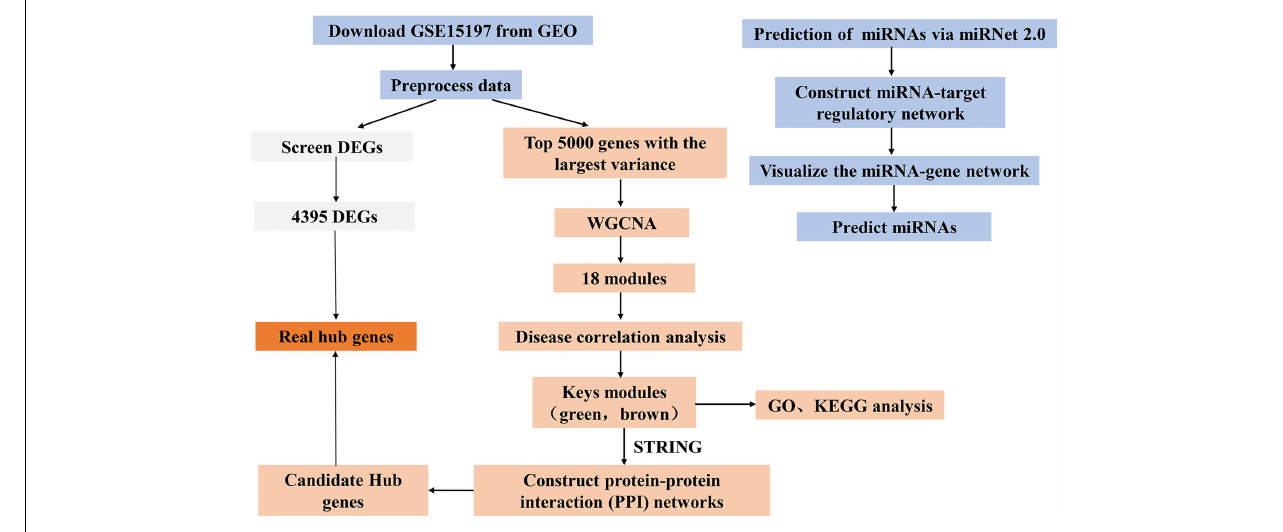
FIGURE 1 | Flow chart for this study. miRNA, microRNA.